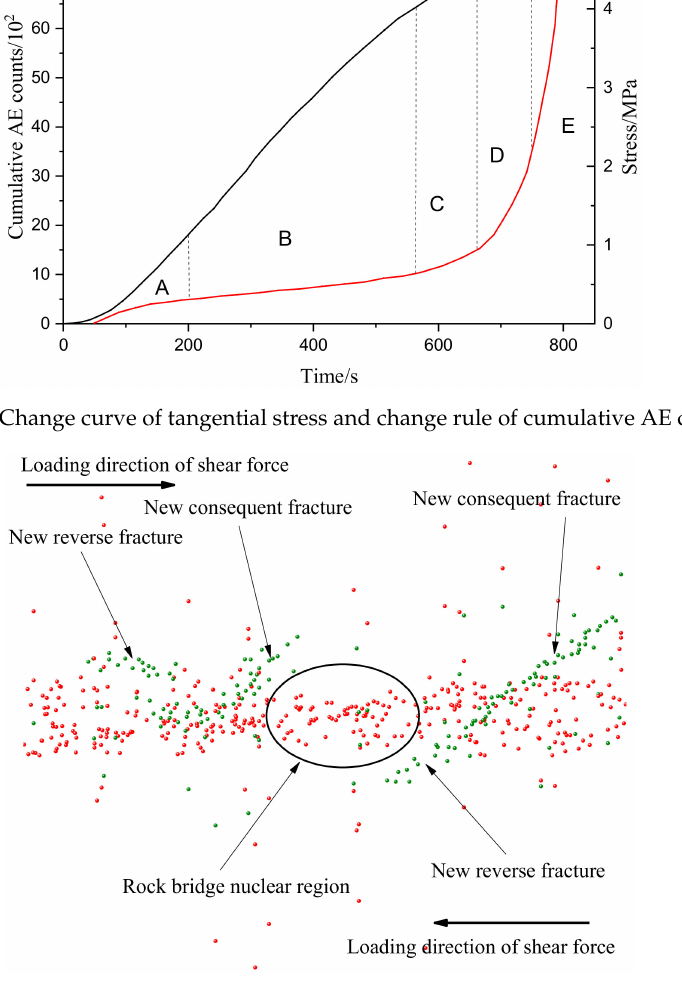
Figure 21. AE location of specimen during direct shear